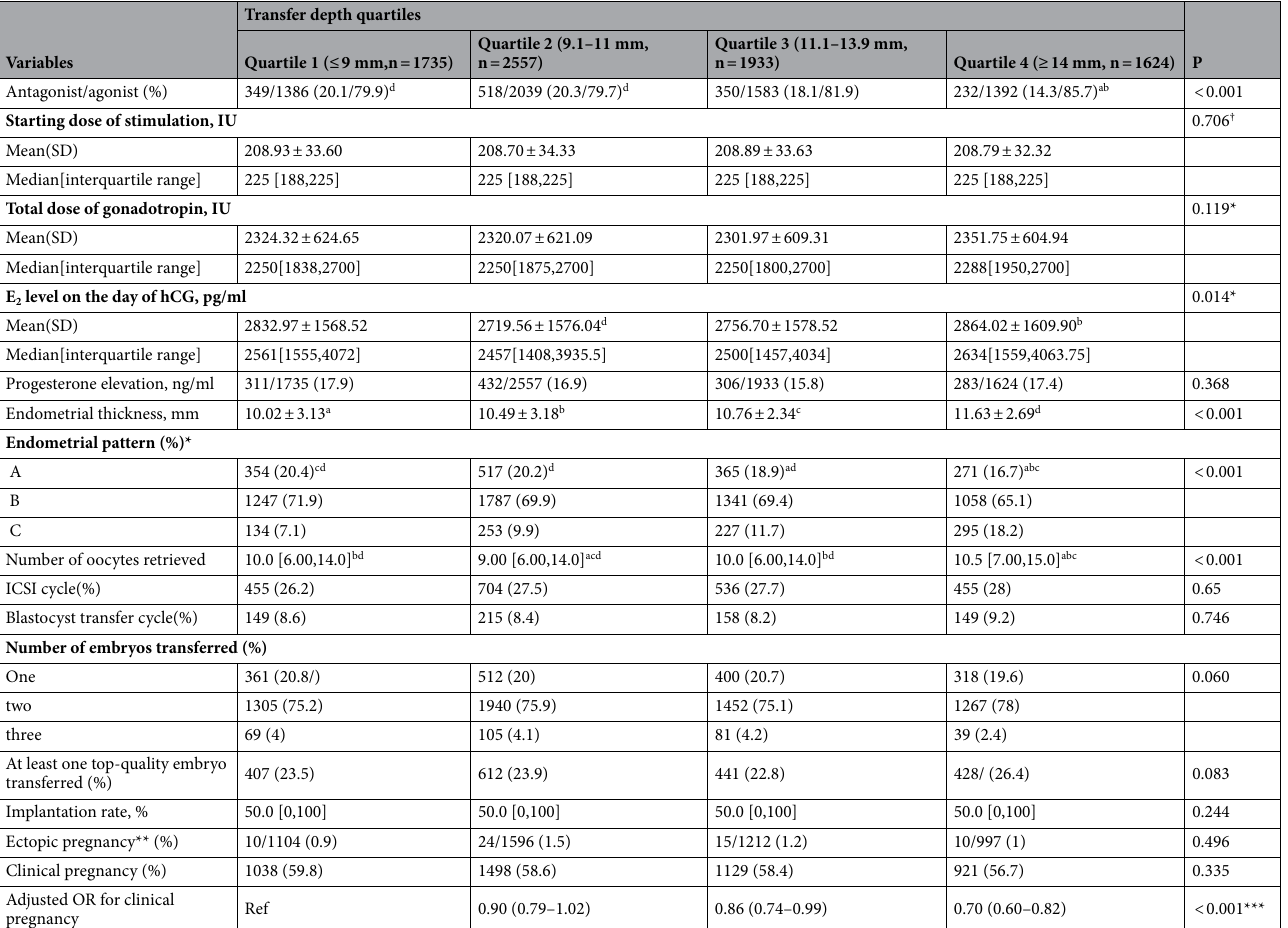
Table 2. Outcome of ovarian stimulation, fertilization and embryo transfer. Data were presented as mean ± SD and median [interquartile range] for continuous variables, and n (percentage) for categorical variables. † Indicates the data were non-normally distributed and analyzed using Kruskal Wallis test. *Indicates the data were normally distributed and analyzed using one way ANOVA. a Indicates that the group differs from quartile 1 at p value of 0.0125; b Indicates that the group differs from quartile 2 at p value of 0.0125; c Indicates that the group differs from quartile 3 at p value of 0.0125; d Indicates that the group differs from quartile 4 at p value of 0.0125. *Pattern A: a triple-line pattern consisting of a central hyperechoic line surrounded by two hypoechoic layers, pattern B: an intermediate isoechogenic pattern with the same reflectivity as the surrounding myometrium and a poorly defined central echogenic line, and pattern C: homogenous, hyperechogenic endometrium. **Ectopic pregnancy rate = ectopic pregnancies /(chemical pregnancies + clinical pregnancies + ectopic pregnancies). ***P for trend, ORs were adjusted for female`s age, duration of infertility, hydrosalpinx, the number of oocytes retrieved, starting dose of stimulation, type of GnRH analogues, the number of embryos transferred, endometrial thickness, endometrial pattern, progesterone elevation, the development stage of transferred embryos, the presence of at least one good-quality embryo transferred and providers of embryo